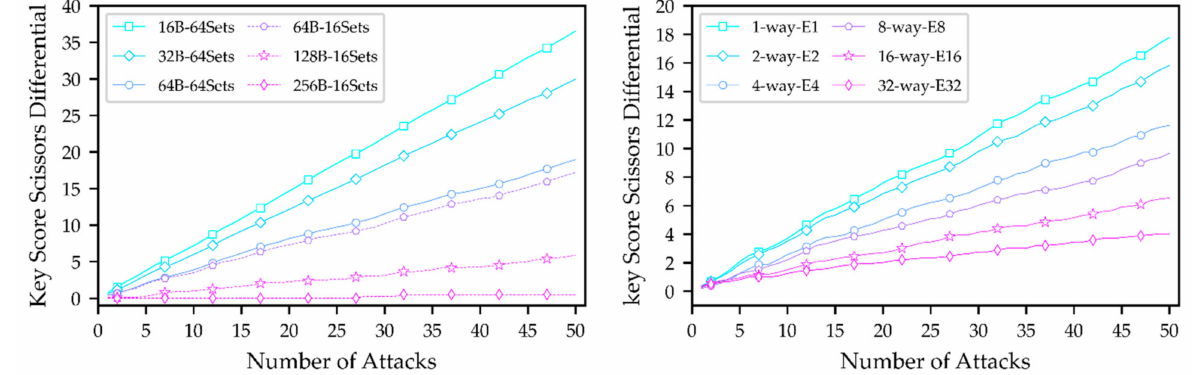
Figure 5. Evaluation of cache line size ( left ) and private cache associativity ( right